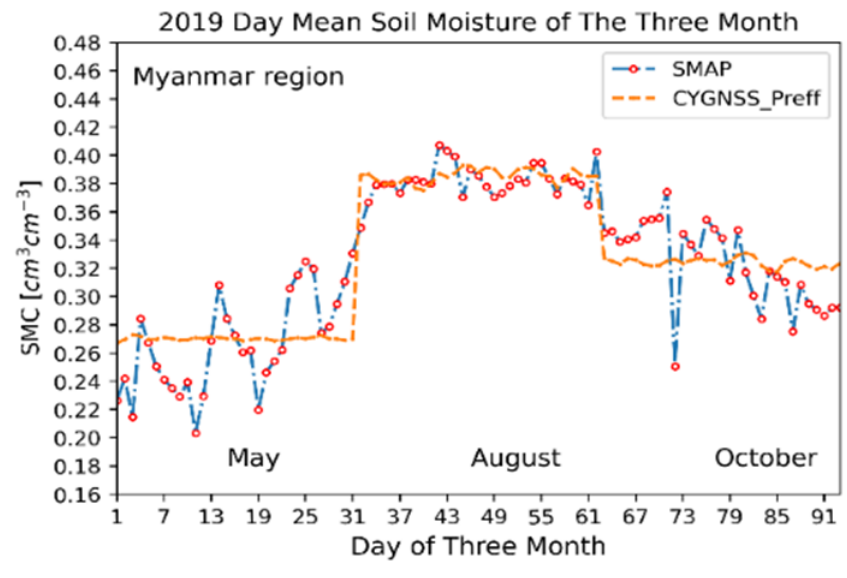
Figure 11. CYGNSS surface reflectivity and SMAP mean SM in May, August, and October 2019.